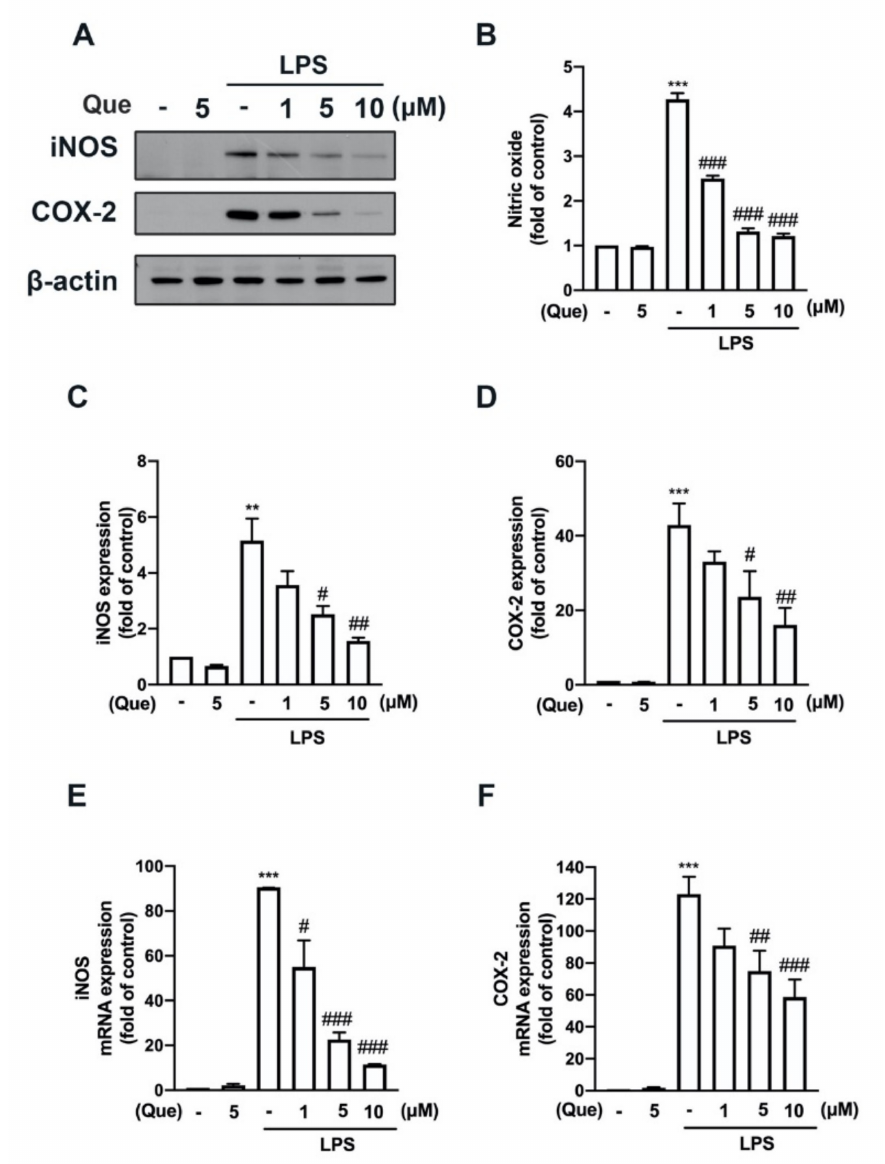
Figure 3. Inhibitory effects of quercetin on iNOS and COX-2 expression levels in microglial cells. IMG cells were stimulated with various concentrations of quercetin (1, 5, or 10 µ M) for 30 min, followed by stimulation with LPS (50 ng/mL) for another 24 or 6 h. iNOS and COX-2 protein levels were determined by western blotting analysis ( A ). ( B ) The supernatant was collected to determine NO production by the Griess reaction. Quantitative results are shown in ( C , D ). mRNA levels of iNOS ( E ) and COX-2 ( F ) were analyzed by real-time PCR and normalized to β -actin. Each bar represents the mean ± SEM of n = 3–4. *** p < 0.005, ** p < 0.01 compared with the control group. Note: ### p < 0.005, ## p < 0.01, # p < 0.05 compared with the LPS alone